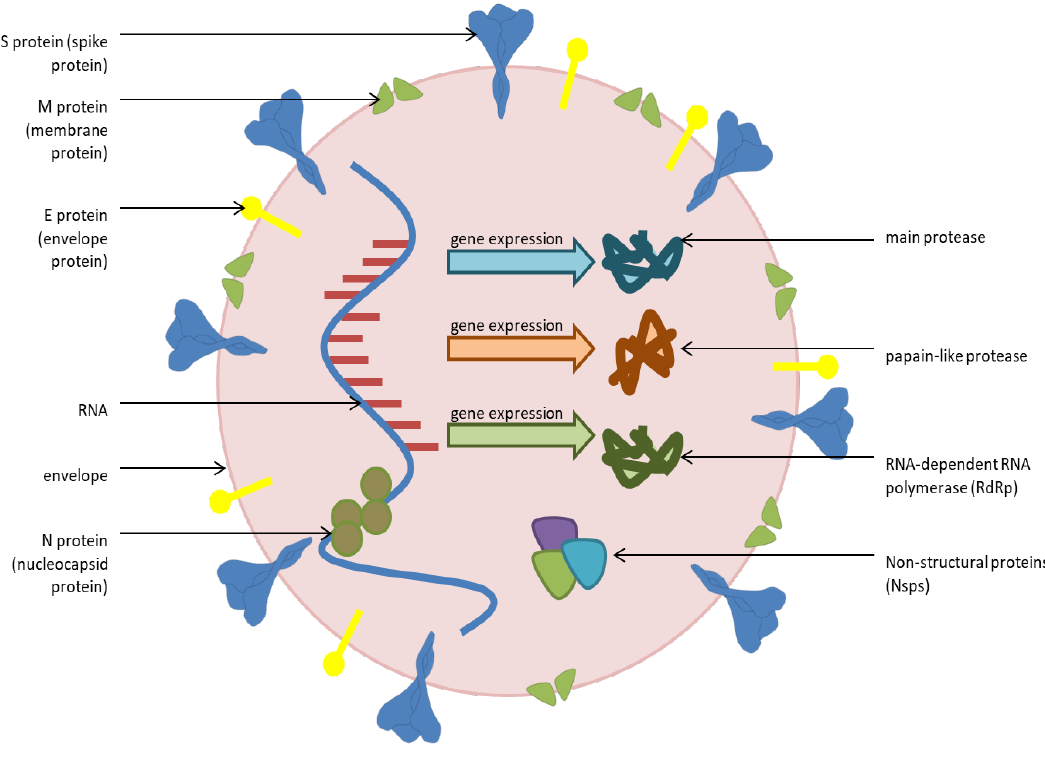
Figure 1. Structure of SARS-CoV-2.